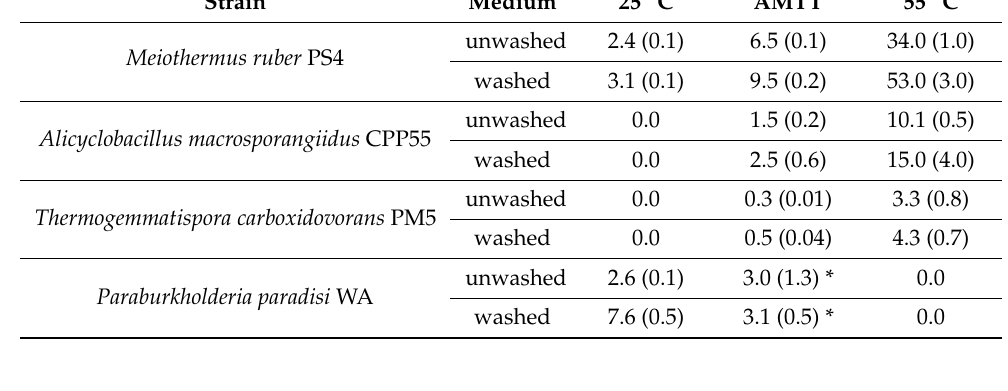
Table 2. CO uptake rates (CO nmol h − 1 (mg protein) − 1 ) for each of the three temperature regimes (values are means of triplicate determinations ± 1 standard error) with unwashed and washed cells as described in the text. Asterisks indicate initial uptake rates for P. paradisi WA during the AMTT incubations prior to the establishment of thermophilic temperatures.